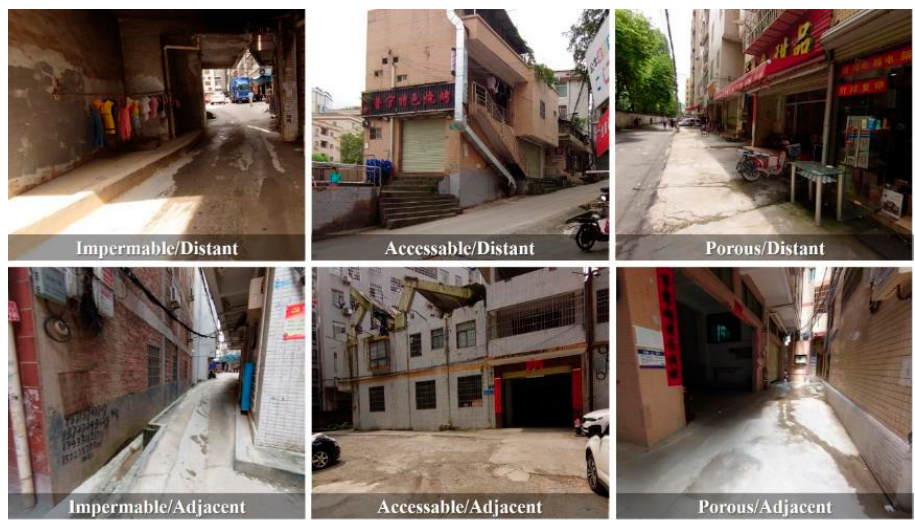
ff erent types of Figure 5. Samples of different types of interfaces. Figure 5. Samples of di